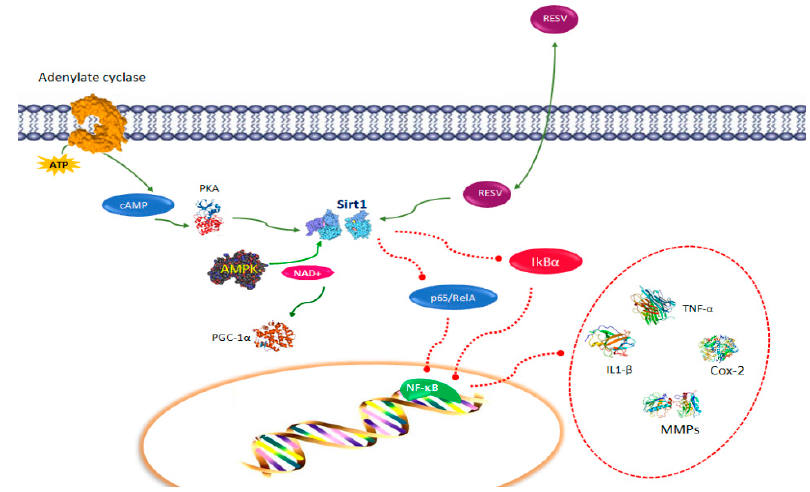
Figure 2. Resveratrol pathways in immune function: resveratrol activates Sirtuin-1 (Sirt1) inhibiting RelA acetylation and promotes inhibitor protein- κ B α (IkB α ) degradation, which decreases nuclear factor kappa B (NF- κ B)-induced expression of tumor necrosis-alpha (TNF- α ), interrleukin (IL)-1 β , IL(-6), metalloproteases (MMPs), and cyclooxygenase Cox-2. Cyclic adenosine monophosphate (cAMP) levels trigger protein kinase A (PKA), which activates Sirt1. AMP-activated protein kinase (AMPK) controls the activity of Sirt1 by regulating the cellular levels of nicotinamide adenine dinucleotide (NAD + ). In the downstream activation of AMPK, an increase of NAD + levels induces Sirt1 activation, which promotes deacetylation and activation of peroxisome proliferator-activated receptor gamma coactivator 1-alpha (PGC-1 α ).